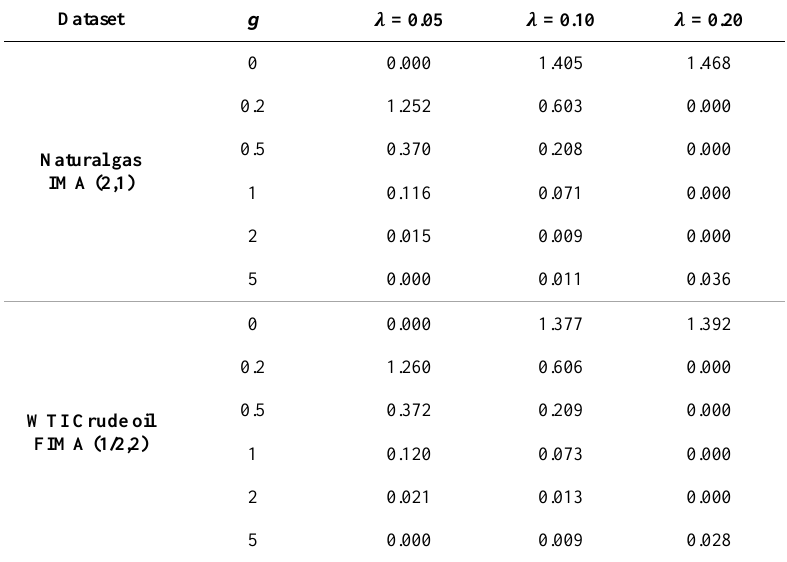
Table 9. Compare the RMI of two datasets at various